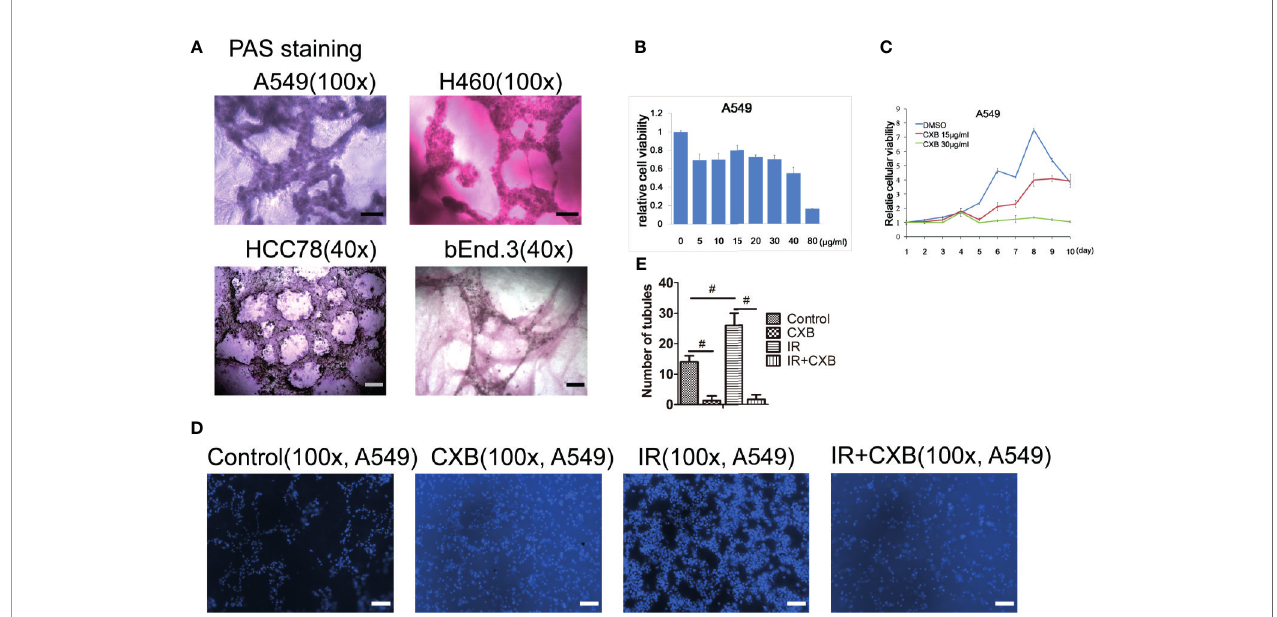
FIGURE 2 | CXB exerted radiosensitizing effect via inhibiting VM formation. (A) VM formation in A549, H460, HCC78, and bEnd.3 cells grown on the 3D Matrigel in representative images with PAS staining. Scale bar, 500 m m. (B) The in fl uence of CXB at different doses treated for 24 h on A549 cells analyzed by CCK-8 assay. CXB at a dose of 15 µg/ml did not dramatically inhibit the growth of A549 cells. (C) The in fl uence of DMSO, and 15 and 30 µg/ml of CXB treatment for different durations on A549 cells analyzed by CCK-8 assay. CXB treatment at a dose of 15 µg/ml for 10 days did not dramatically inhibit the growth of A549 cells. (D) Pictures of tubules in different groups in A549 cells. (E) The number of tubules in different groups (the control, CXB, IR, and IR plus CXB groups) in A549 cells. Data are expressed as the mean ± SEM ( n = 3). # p < 0.001. Scale bar, 500 m m. CXB, celecoxib; VM, vasculogenic mimicry; PAS, periodic acid solution; DMSO, dimethyl sulfoxide; IR,